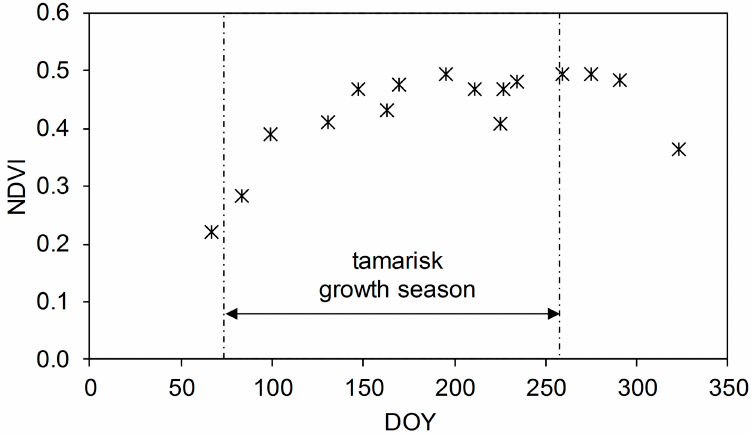
Figure 2. Average Normalized Difference Vegetation Index (NDVI) of the study area for all cloud-free Landsat scenes in 2008. DOY, day of year.